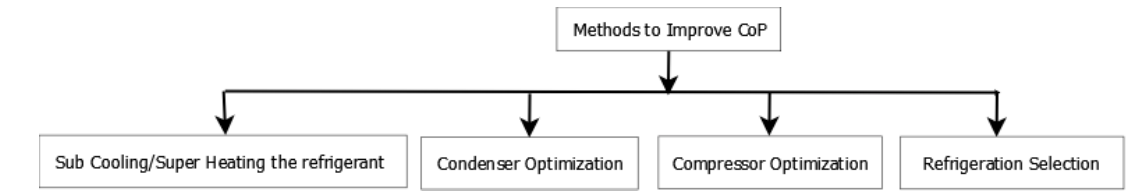
Figure 4. P-H diagram of a standard vapor-compression refrigeration system.